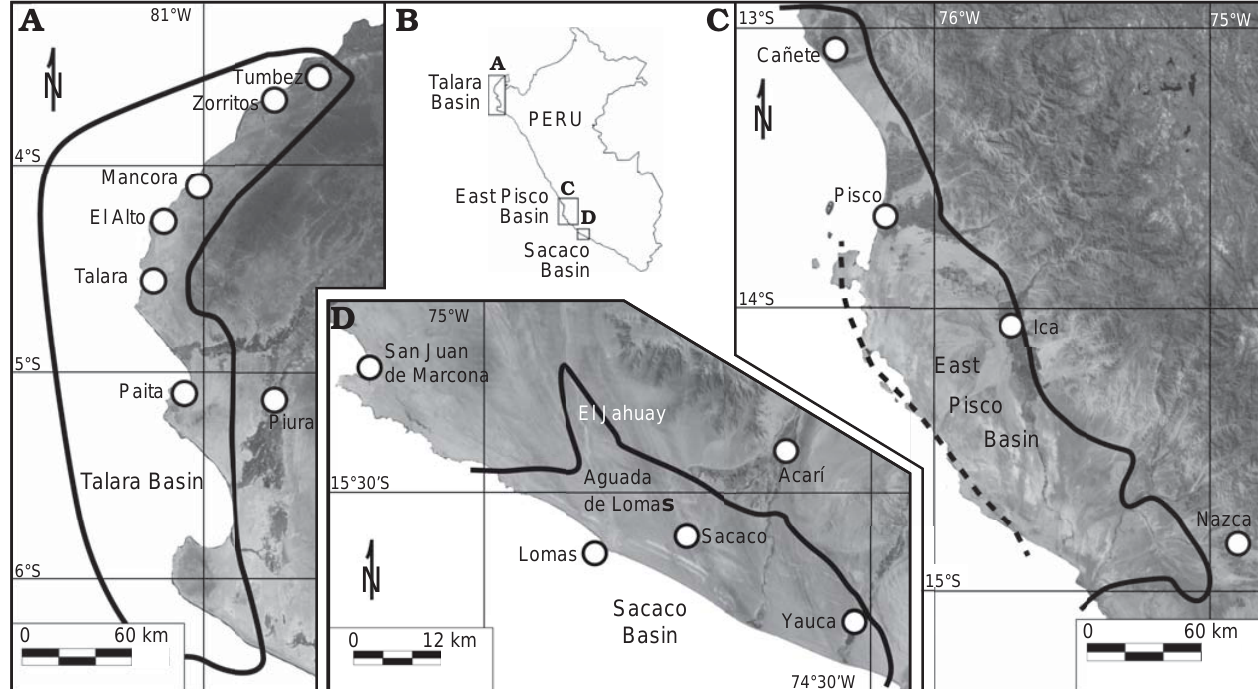
Fig. 1. Forearc basins in Peru with crassatelline-bearing Cenozoic deposits. A . Talara Basin of northern Peru. B . Location of three crassatelline-bearing Peruvian forearc basins. C . East Pisco Basin of south-central Peru. Dashed black line marks the inferred boundary between the East and West Pisco basins. D . The much smaller Sacaco Basin of southern